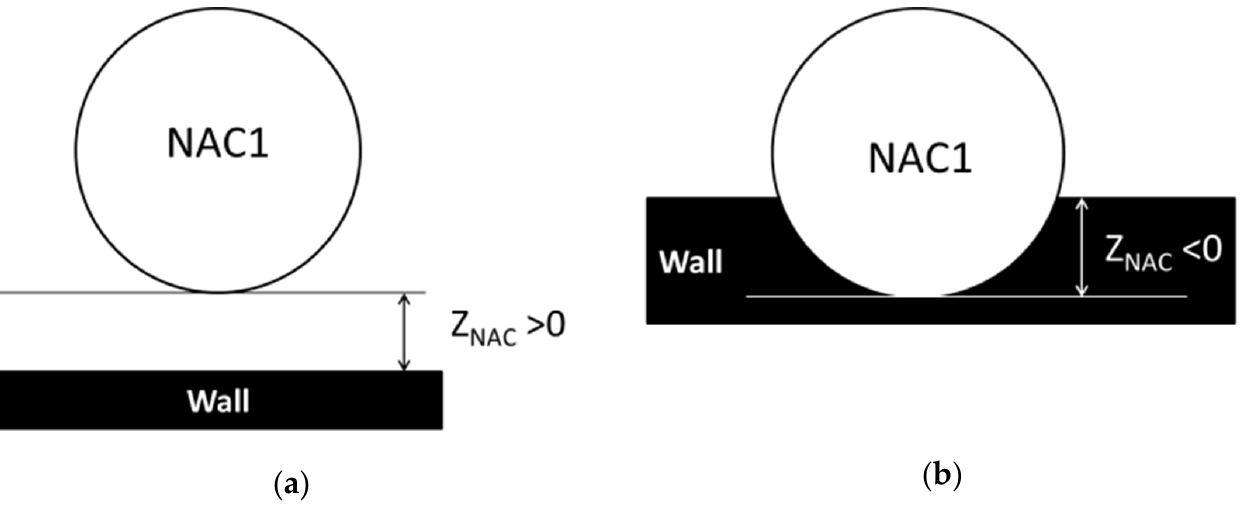
Figure 13. Definition of the Z NAC parameter. ( a ) “Standard”. ( b ) “Buried”.